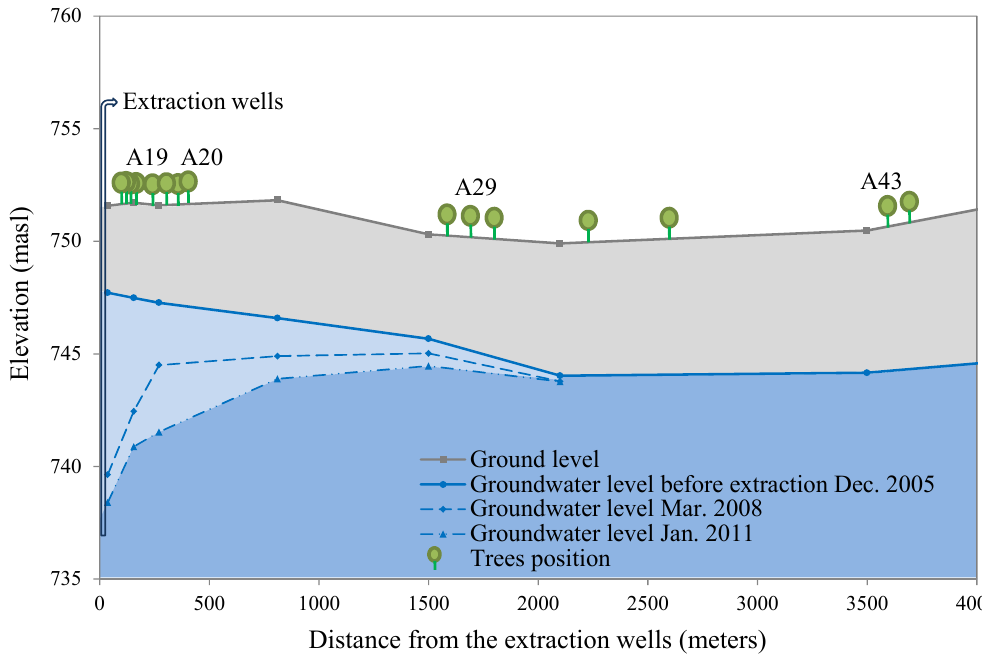
Figure 2. Vertical profile showing the distance of the Tamarugo trees from the extraction wells in the Llamara forest and ground water level in 2005 (before extraction), 2008 and